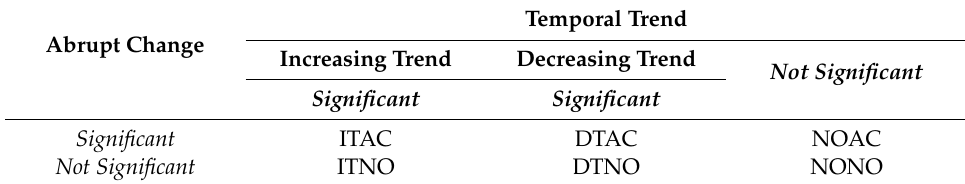
Table 1. Di ff erent types of temporal patterns defined in this